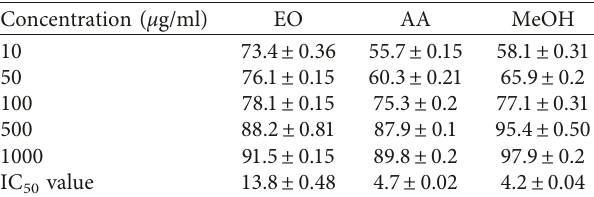
Table 7: Percentages and IC 50 values ( μ g/ml) for radical scavenging activity of EO and extracts (mean standard